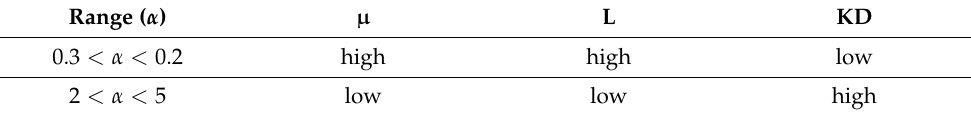
Table 8. Fluctuation range of parameter α in terms of numerical variations KD-L- µ